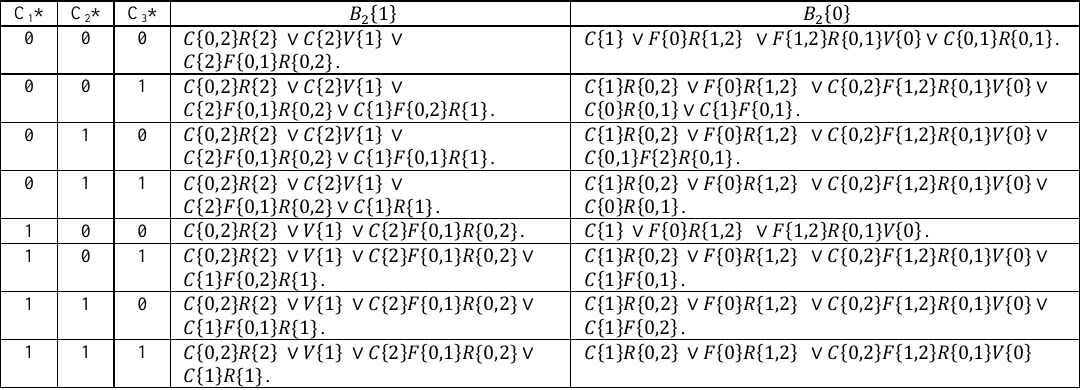
Table 1. Eight possible solutions for each of 𝐵